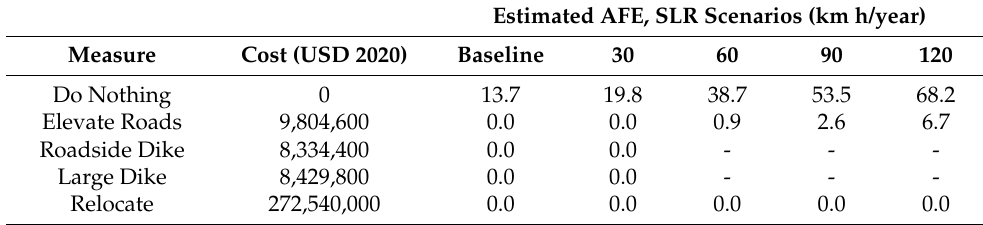
Table 9. Estimated costs and AFE excluding the airport access